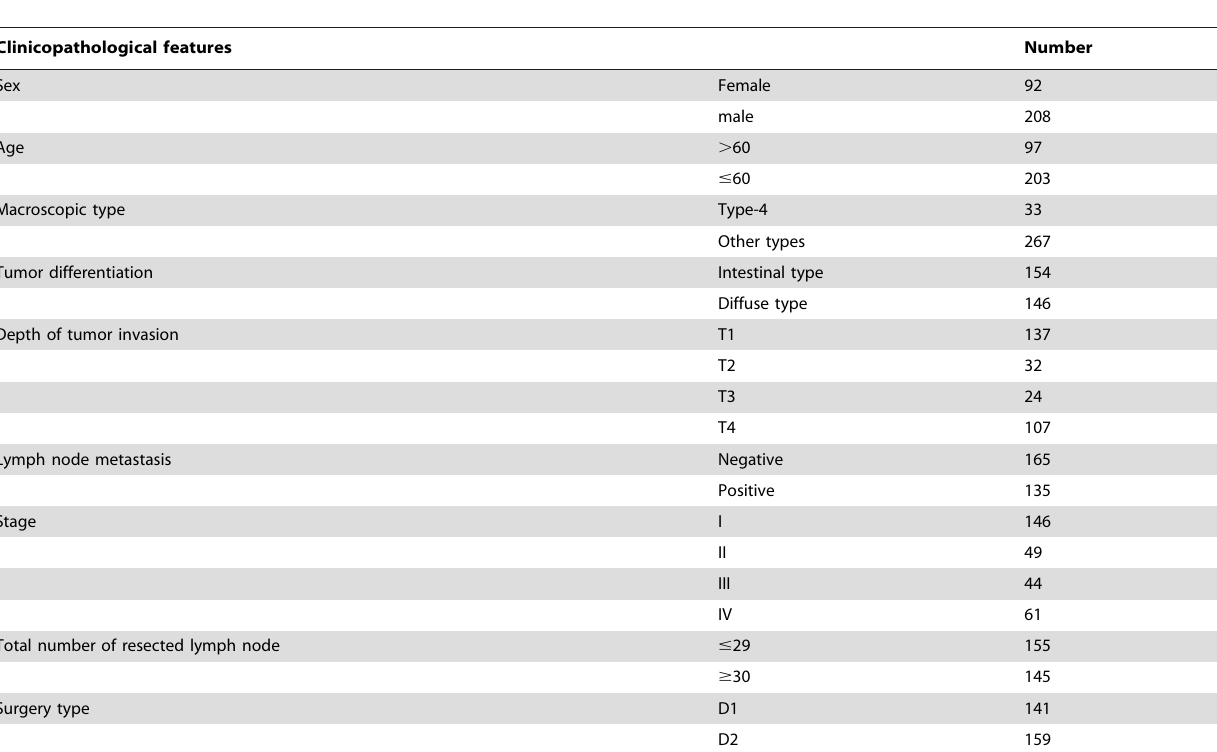
Table 1. Clinicopathological characteristics of 300 gastric cancer